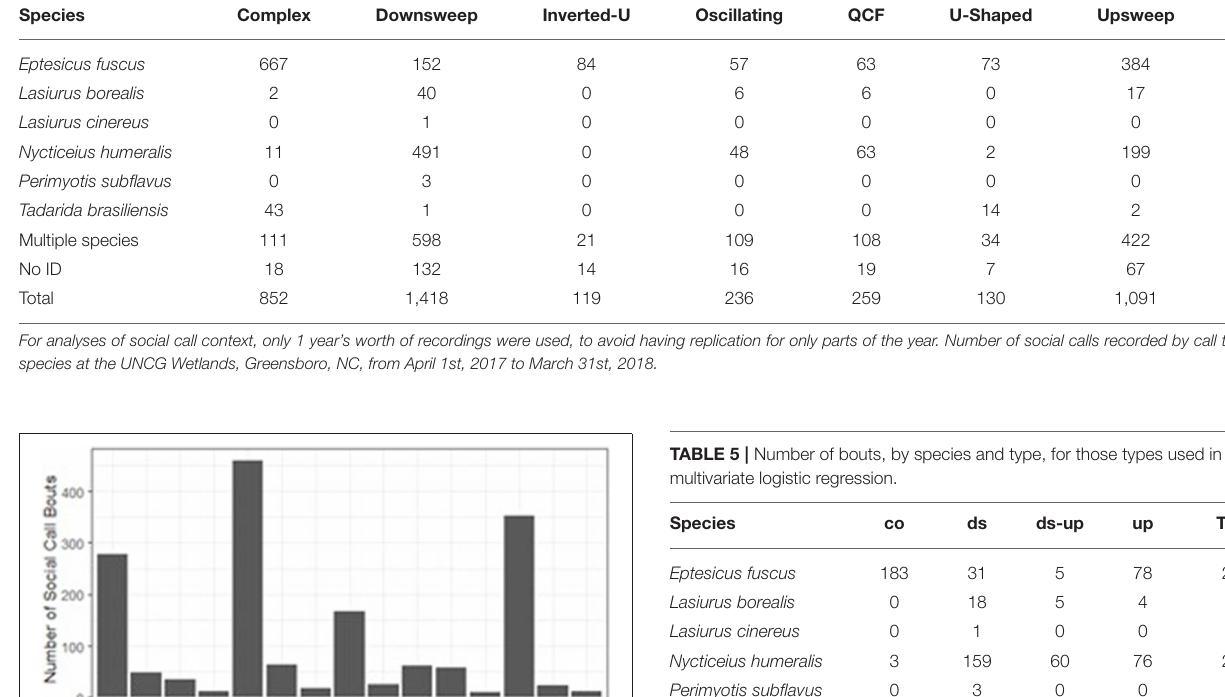
TABLE 4 | Number of social calls, by species and type, used for analyses of call context. Species Complex Downsweep Inverted-U